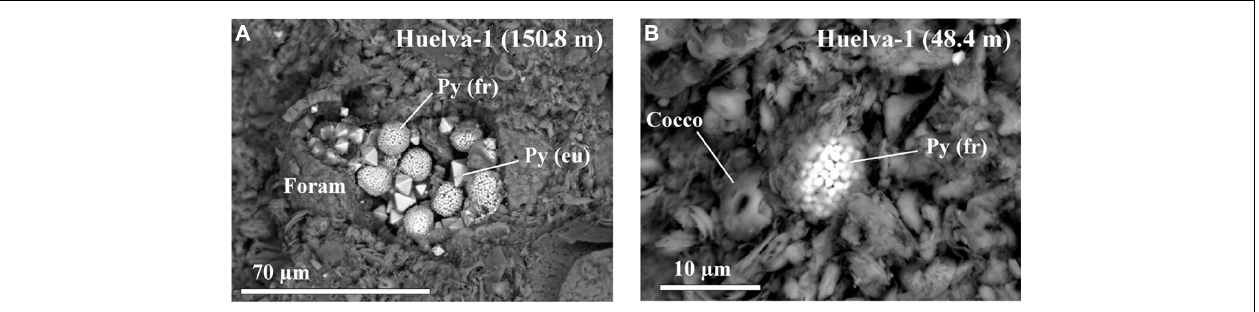
FIGURE 9 | Representative back-scattered scanning electron microscope images of pyrite microtextures in the Gibraleón Formation clays. (A) Framboidal and euhedral pyrite infilling a calcareous foraminifer shell dispersed within a matrix dominated by clays and quartz.